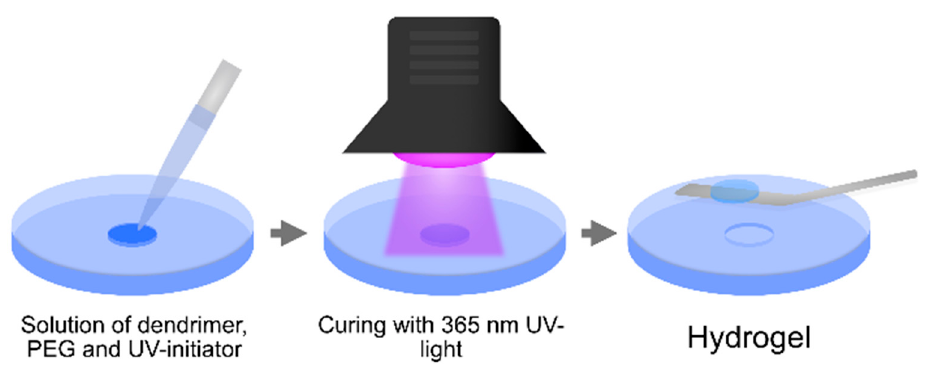
Figure 1. Functional dendritic hydrogels were formed from solutions of dendrimer, dithiol-functional PEG and photoinitiator in equal parts ethanol and water. The solutions were cured under a UV-lamp with peak emission at 365 nm.